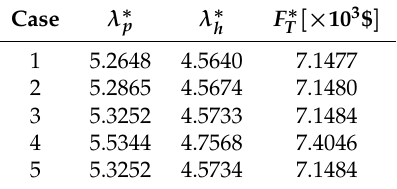
Table 2. The optimal Lagrangian multipliers and minimum total system operation cost.